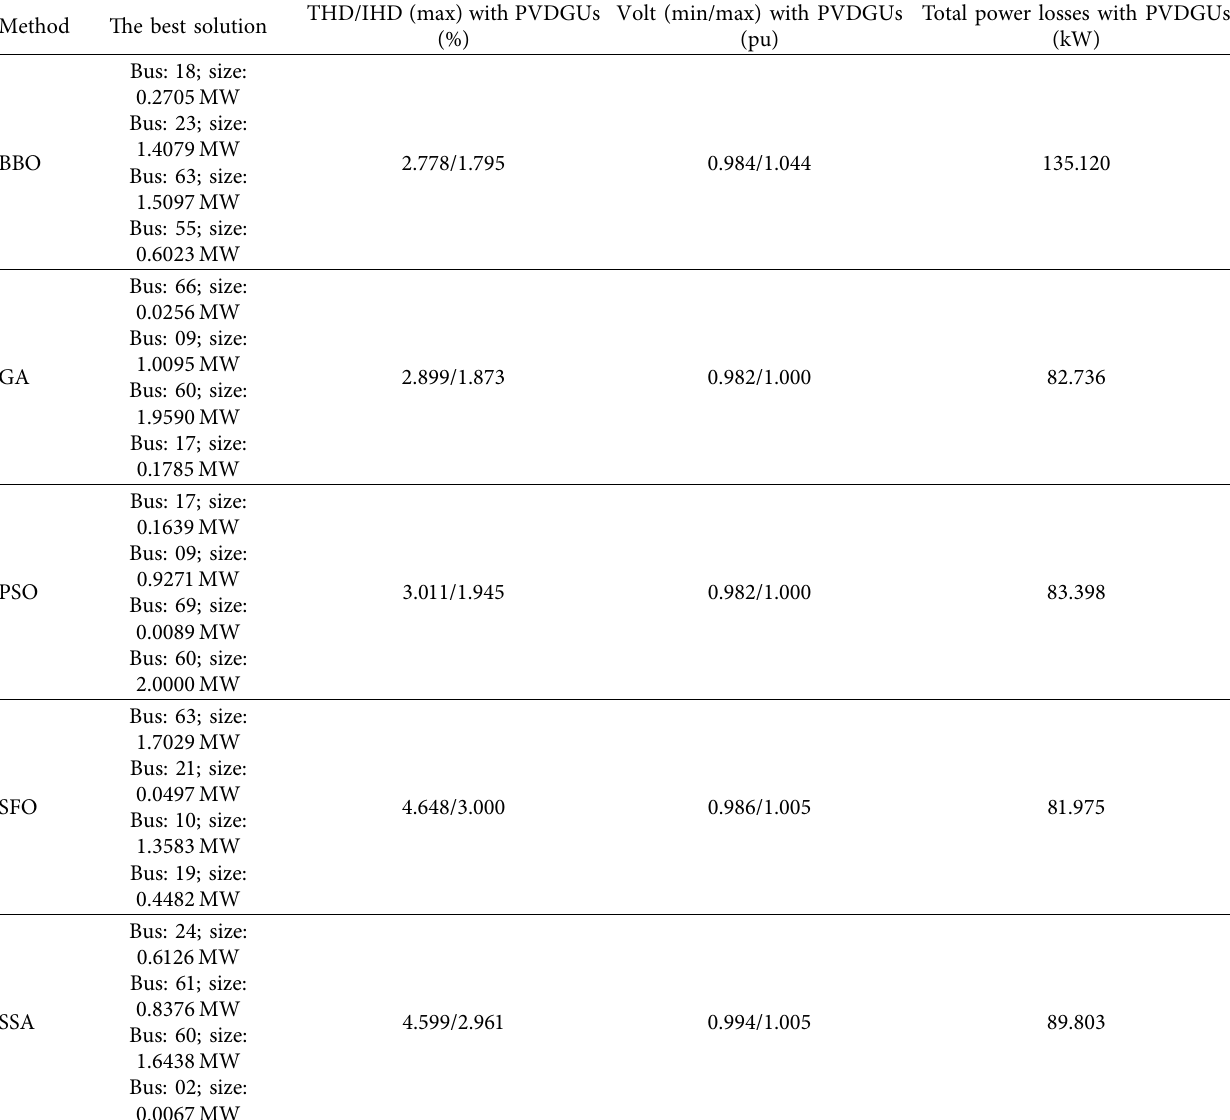
Table 19: The best solutions and the total capacity of PVDGUs found by nine implemented methods for the IEEE 69-bus distribution network in Case